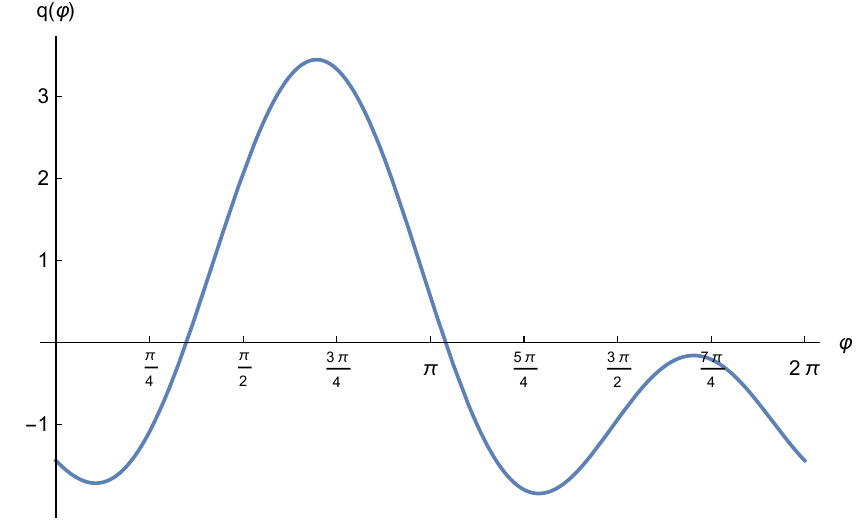
Figure 7. Graph of the function q ( ϕ ) (as defined in Equation (63)) in the interval [ 0,2 π ]